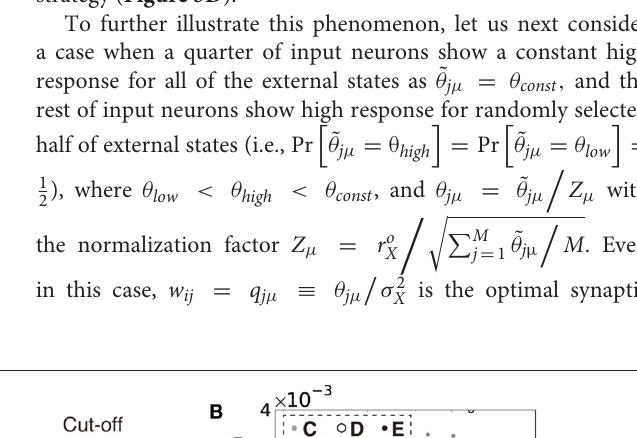
Frontiers in Neural Circuits |